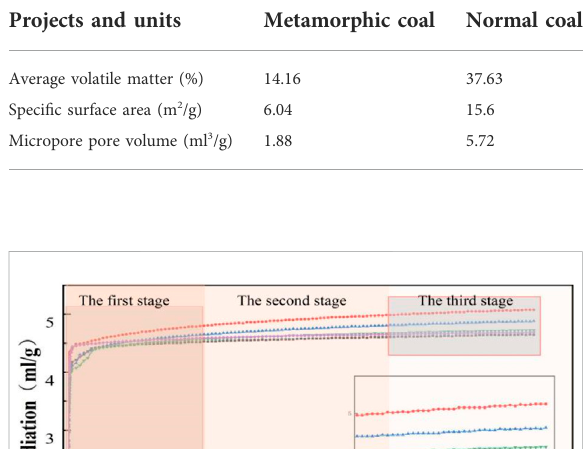
TABLE 3 Characteristic parameters of microporous pores.